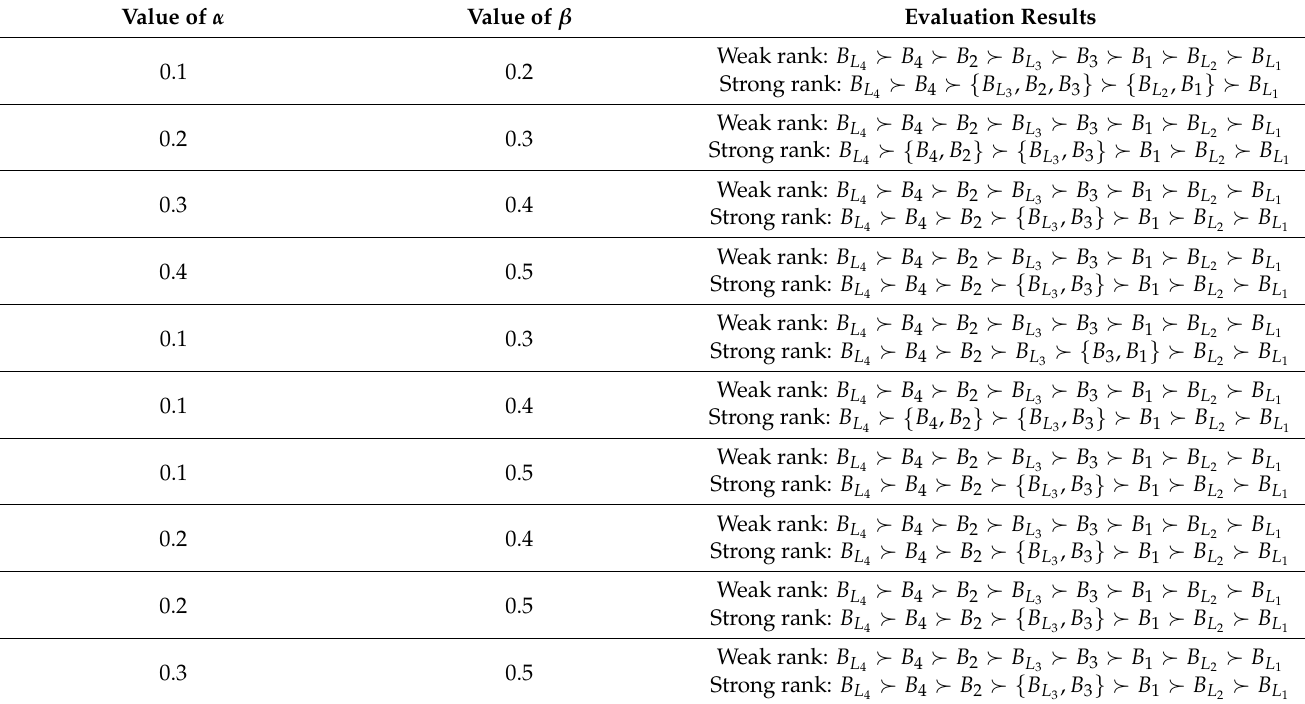
Table 13. Evaluation results under different α and β values.